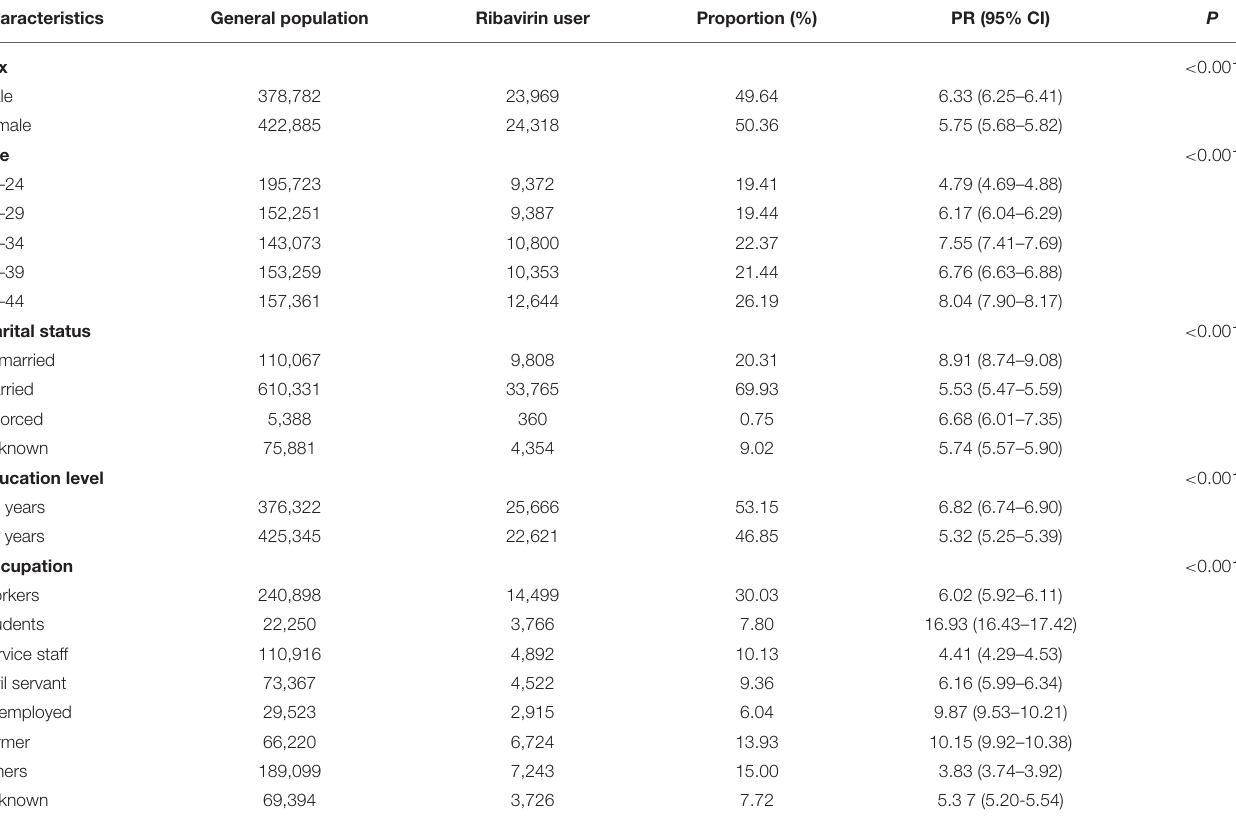
TABLE 1 | Baseline characteristics of general population and patients exposed to the IV ribavirin. Characteristics